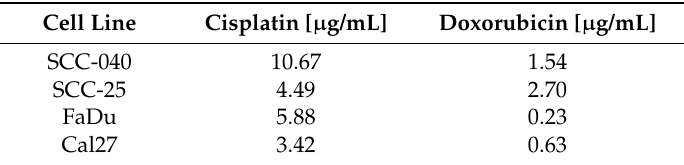
Table 1. Half maximal inhibitory concentration (IC 50 ) values of cisplatin and doxorubicin for head and neck squamous cell carcinomas (HNSCC) cell